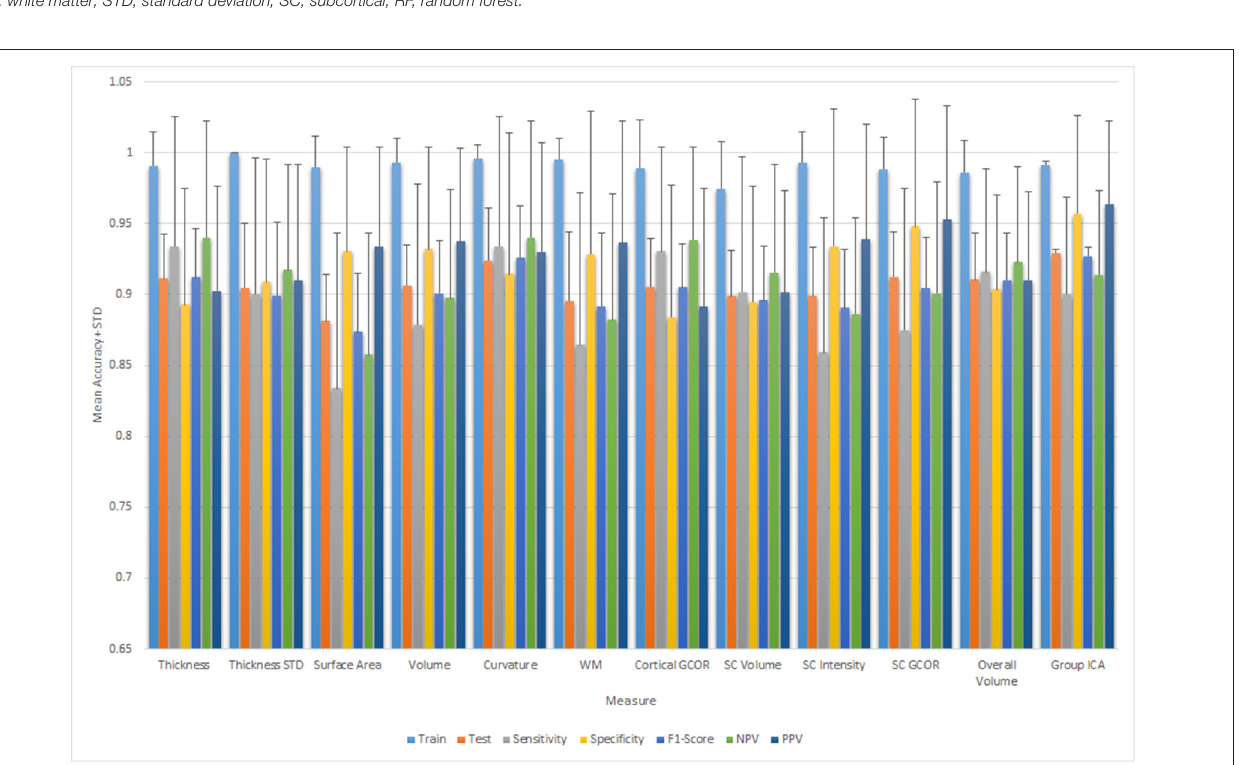
and white matter abnormalities (Davis et al., 2003; Kubicki et